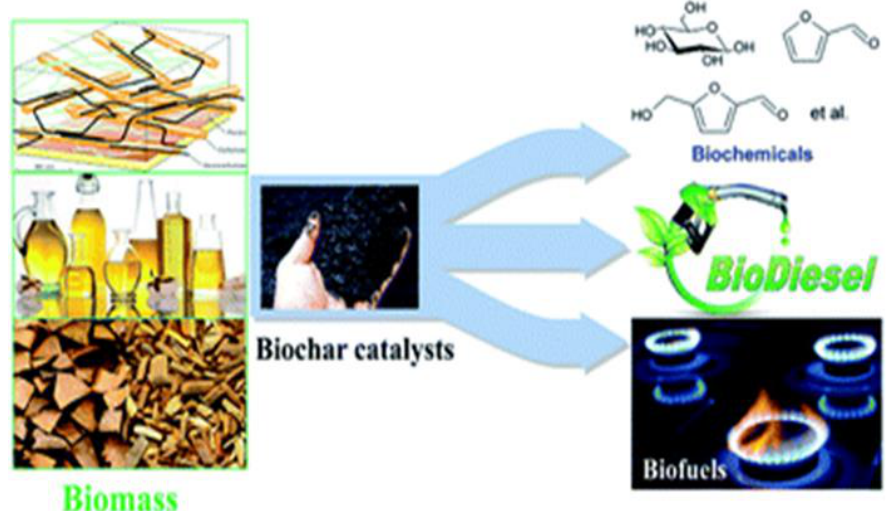
Adapted with permission from ref. [26]. Figure 5. Catalysts based on biochar are used in biomass upgrading.